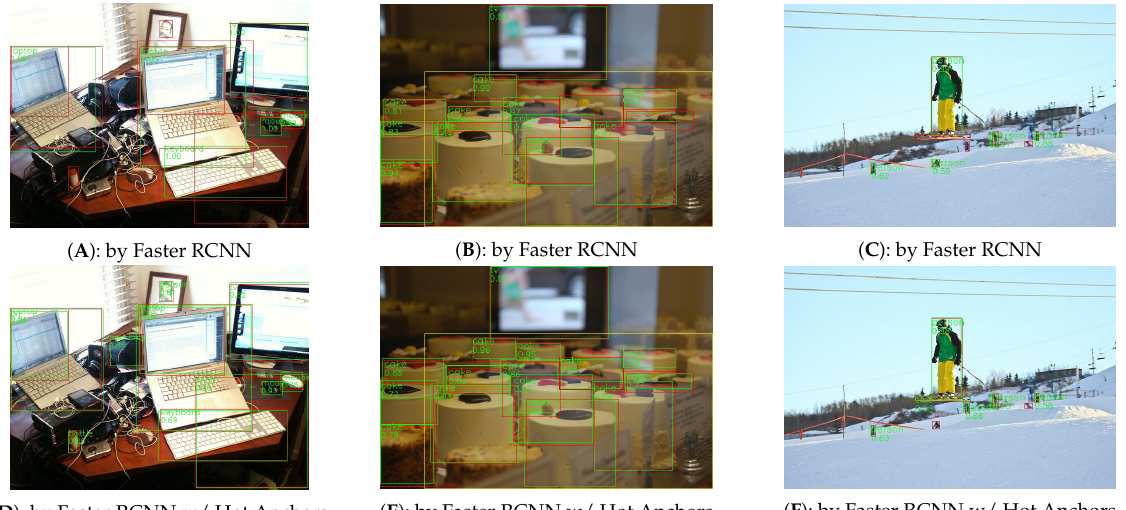
Figure 9. The comparison of detection results between Faster RCNN [7] and Faster RCNN with Hot Anchos. The ( A – C ) are the results detected by Faster RCNN, and the ( D – F ) are the results detected by Faster RCNN with Hot Anchors . The green boxes tagged by class label and classification score are the detection results, while the red boxes are the ground-truth boxes. All the images come from COCO2014-minival-set and have been resized to the same size for convenient